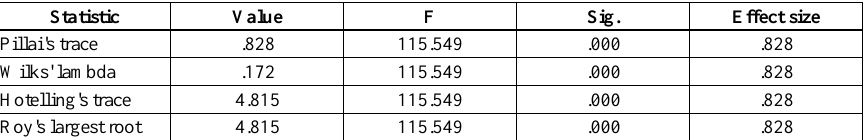
Table 2. Multivariate test